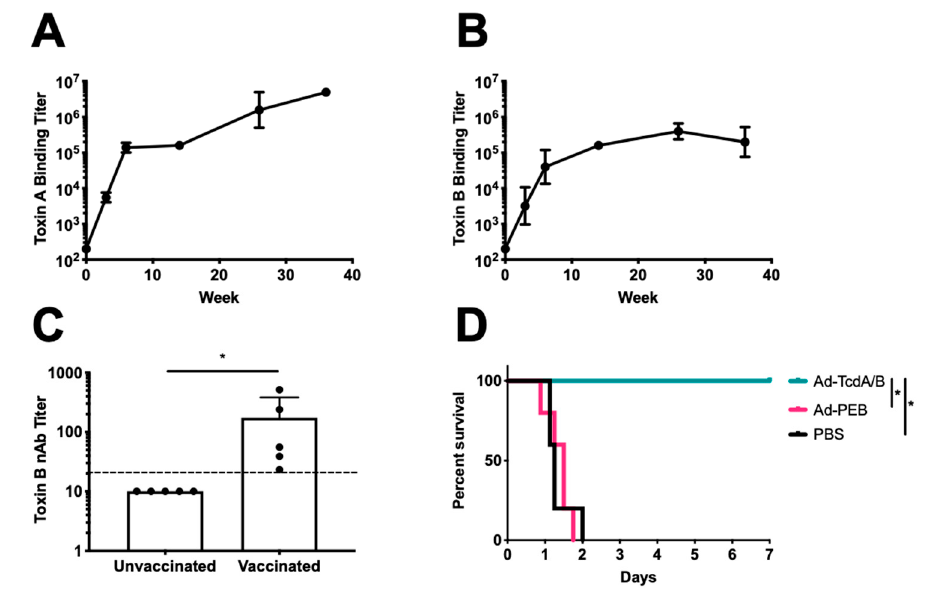
Figure 2. SC-Ad6-TcdA / B provides protection against lethal challenge long after single immunization. Female CD-1 mice (n = 5) were vaccinated i.m. with 1 × 10 10 virus particles of SC-Ad6-PEB1, SC-Ad6-TcdA / B, or PBS. Serum collected at weeks 3, 6, 14, 26, and 36 were titrated to determine binding endpoint titers for ( A ) toxin A and ( B ) toxin B. In both panels, points show geometric mean and bars show standard deviation. ( C ) Mean neutralizing titers for toxin B were significantly higher in the SC-Ad-TcdA / B than SC-Ad-PEB1 immunized animals. Columns show mean; bars show standard deviation; the dotted line indicates the limit of detection; (* p < 0.05). ( D ) Survival curve for SC-Ad-TcdA / B vaccinated mice challenged with toxin A shows significant protection compared to PBS or PEB1 control animals (* p <